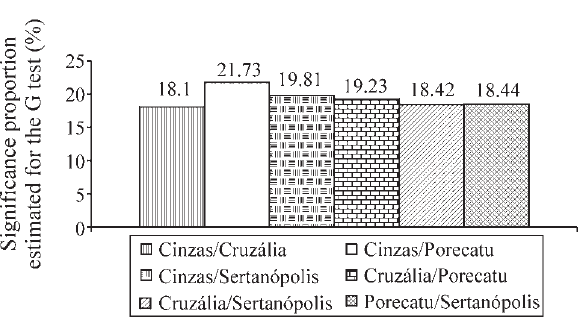
Figure3 -ProportionofRAPDpolymorphicloci(95%criterion)withsig- nificant differences (by G-test) in allele frequencies between A. altiparanae samples from each pair of sites at the Capivara Dam.